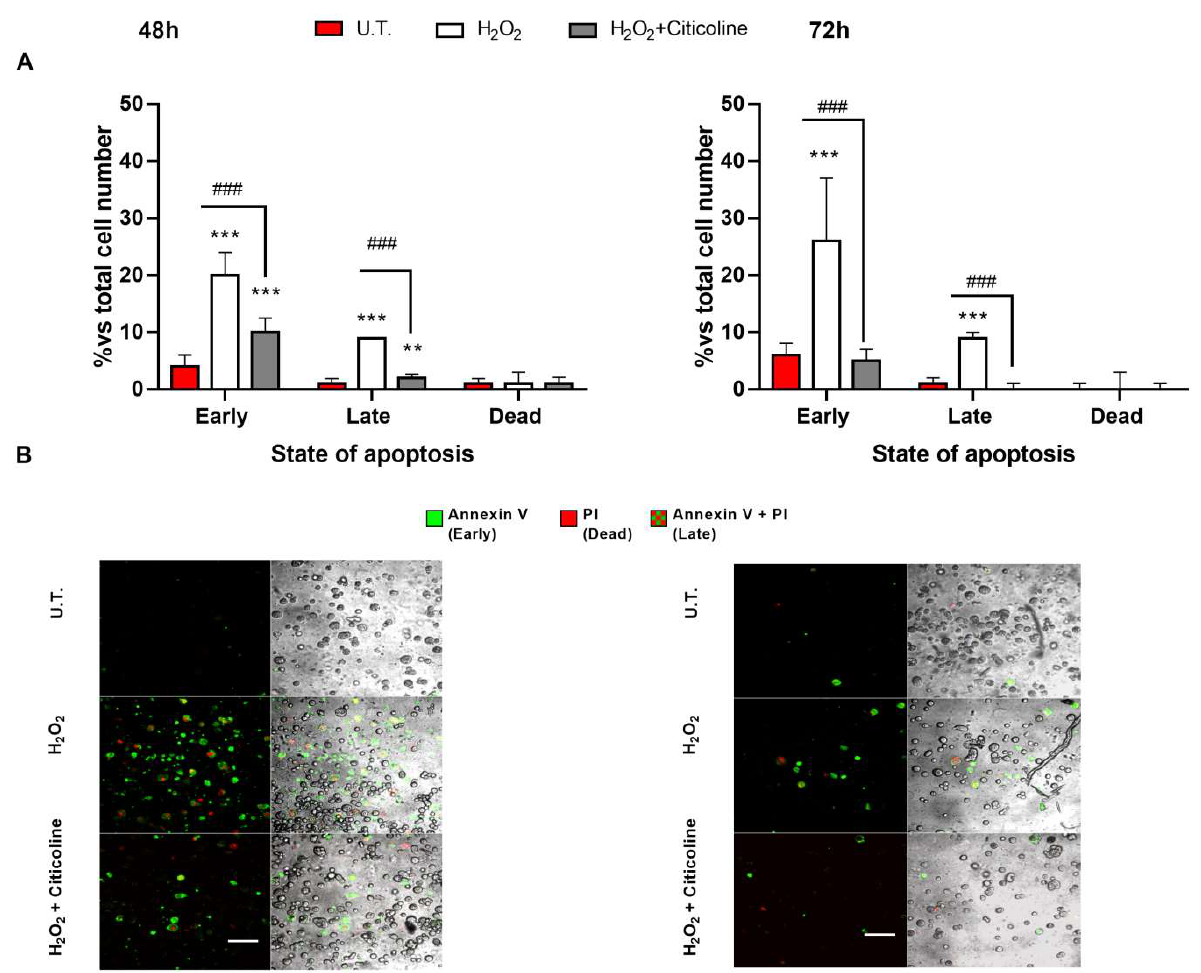
Figure 3. Annexin V binding and PI uptake Annexin V-FITC/PI-staining was used to evaluate the different stages of apoptosis in 3D HTMC. ( A ) The bar chart shows early and late apoptosis and dead cells after 48 and 72 h of experimental procedures. ( B ) Image acquisition was performed using a Leica TSC SP confocal microscope (Leica Microsystem, Wetzlar, Germany). Images depict apoptotic HTMC cells induced by experimental treatments stained with Annexin V-FITC/PI and observed by fluorescence microscopy analysis. The samples were analyzed for green fluorescence (FITC) and red fluorescence (PI). BF images have been added to view the total cell number for each condition (scale bar marker corresponds to 50 µm). *** p < 0.001, ** p < 0.01 vs. untreated (UT) HTMC; ### p < 0.001 vs. treated HTMCs (two-way ANOVA followed by Bonferroni post-test).